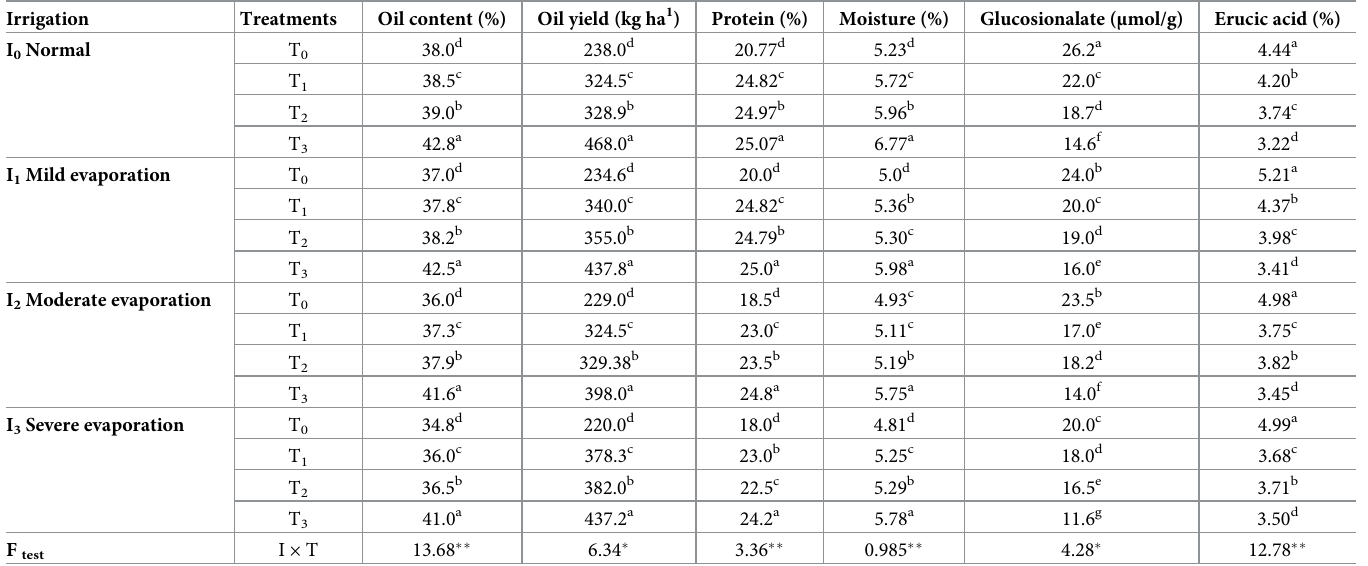
Table 5. Variation in quality traits of canola with chemical fertilizers and plant growth regulators under different water regimes. Irrigation